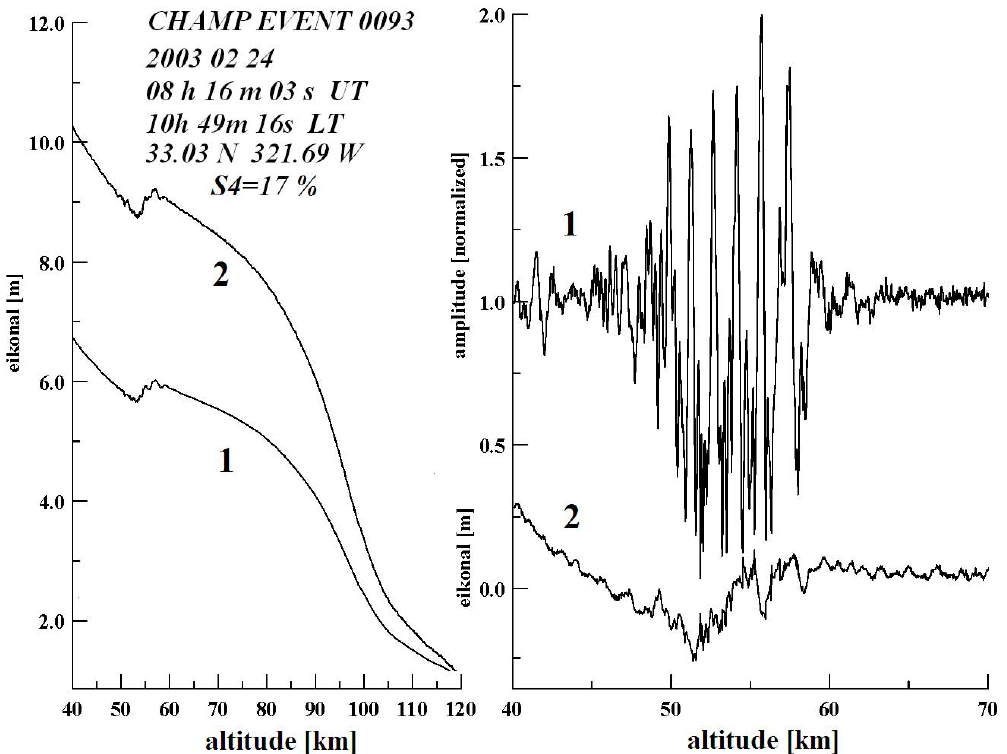
Fig. 3. Quasi-regular variations in the eikonal and amplitude values of the CHAMP RO signals for event no. 0093 (24 February 2003). Left: eikonal variations at frequencies f 1 and f 2 (curves 1 and 2, respectively). Right: the amplitude variations at frequency f 1 (curve 1) and combined eikonal 8(t) (curve